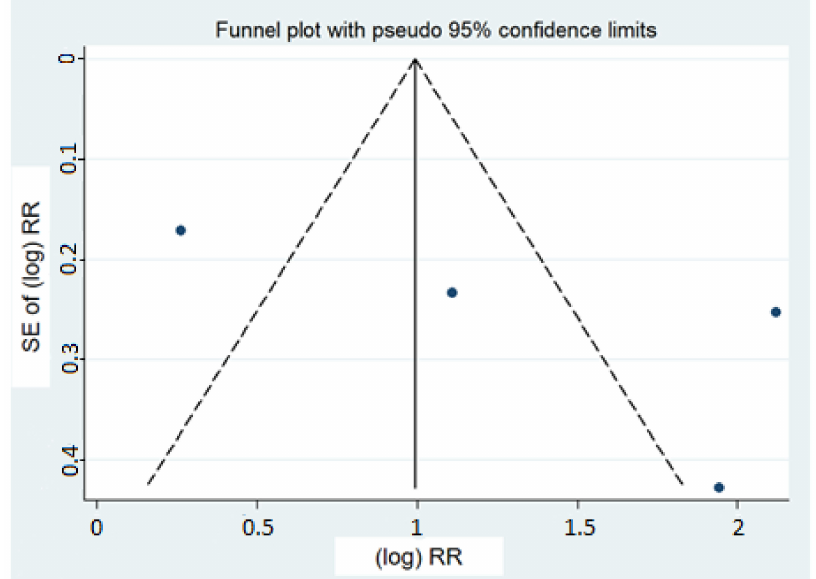
Figure 4. Funnel plot for all of the included studies. SE: standard error; RR: relative